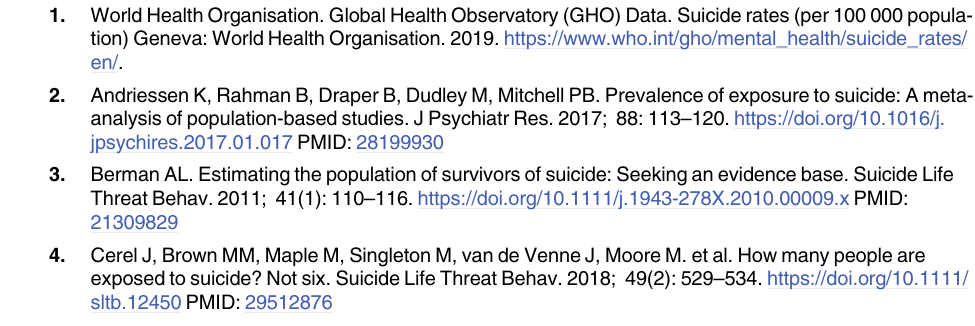
S1 Table. Interview topic guide. S2 Table. Summary of focused codes, sub-categories, categories and core